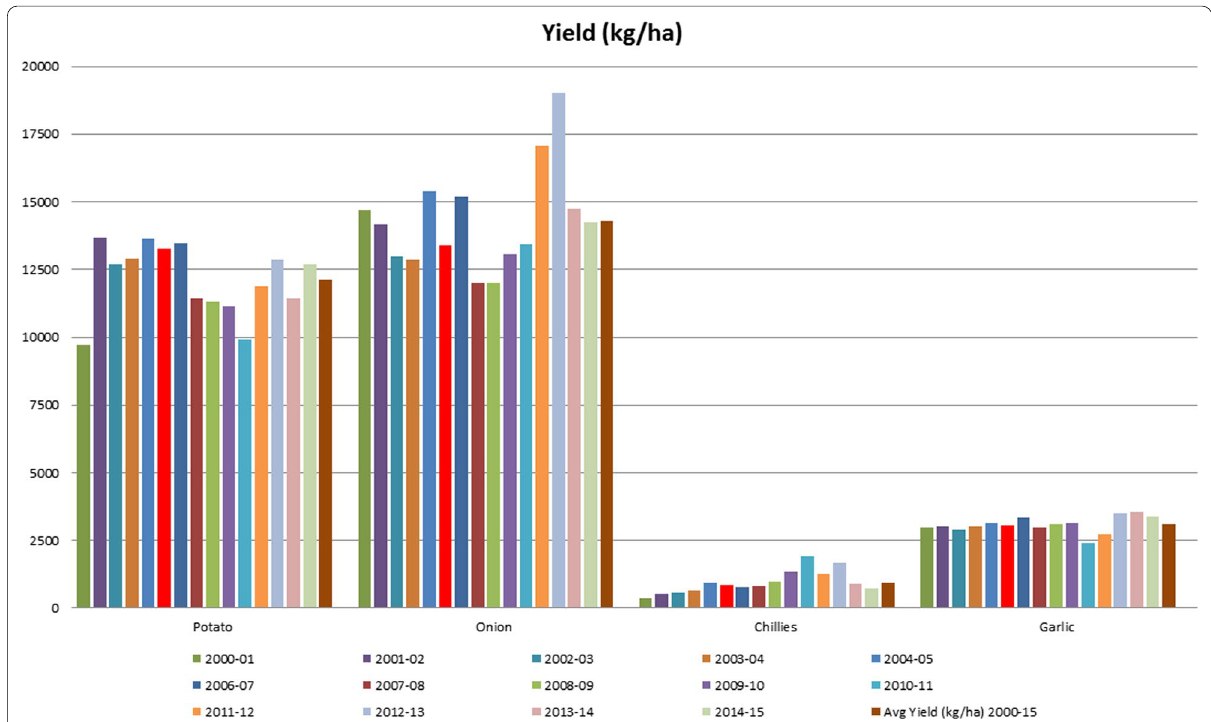
Fig. 22 Comparison of yearly crop yield of potato, onion, chillies, garlic during 2000 to 2015 along with its long-term average yield